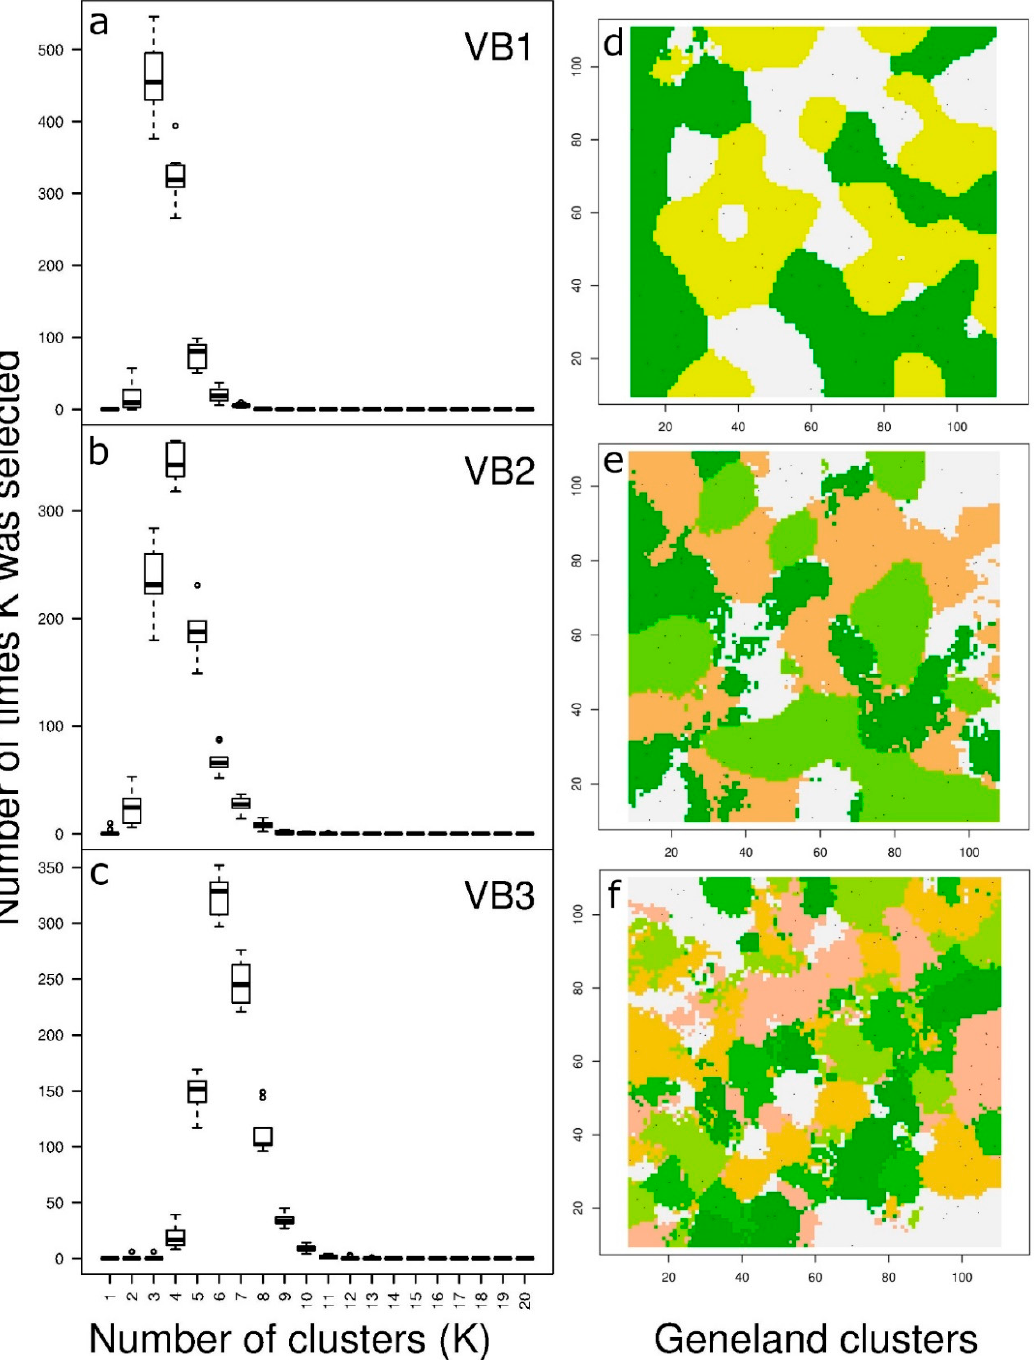
Figure 4. Distributions of results from the 10 repetitions of Geneland analyses for ( a ) VB1, ( b ) VB2 and ( c ) VB3. The highest median number of clusters of the 10 repetitions was chosen as the most representative one for each plot (K = 3 in VB1, K = 4 in VB2, K = 6 in VB3). Maps representing the categorical assignment of individuals to inferred genetic clusters for ( d ) VB1, ( e ) VB2 and ( f ) VB3.